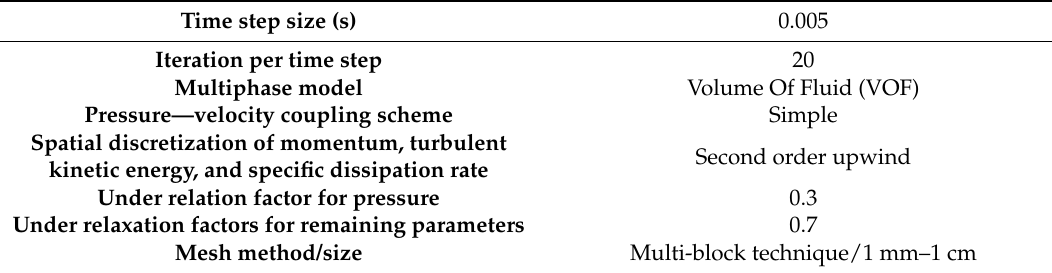
Figure 15. Mesh distribution around the deck. Fine mesh resolution is used near the bridge and at the free surface elevation. Coarser mesh resolution is defined above the free surface where only air exists. Mesh resolution becomes coarser moving away from the deck towards the inlet and outlet. Near the deck, the mesh is flexible quadrilateral, while it is rectangular elsewhere. The inset shows a magnified view of the flexible quadrilateral mesh for the case of the three-girder bridge used in Section 3.2.5 below. Table 5. Summary of the numerical configuration.